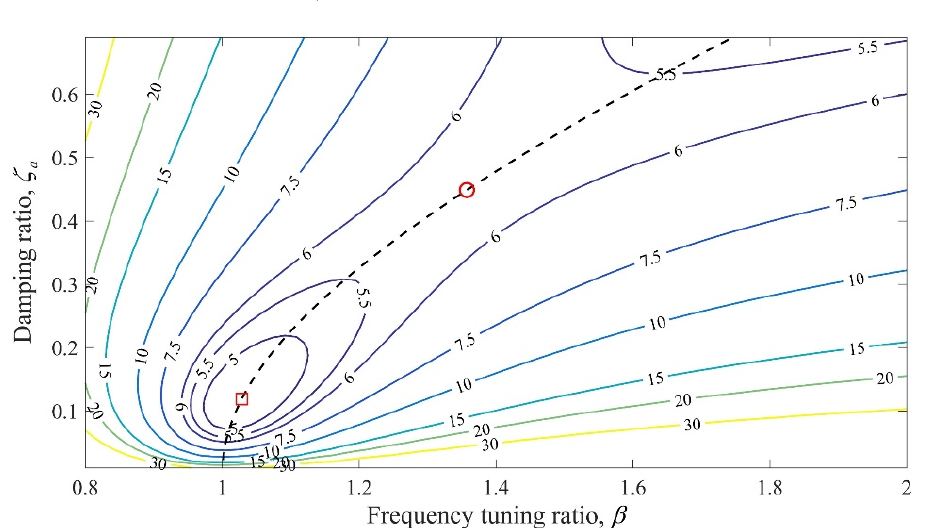
Figure 2. Contour plot of I p superimposed with the solution (black dashed line) of Equation (25) when µ = 0.05.